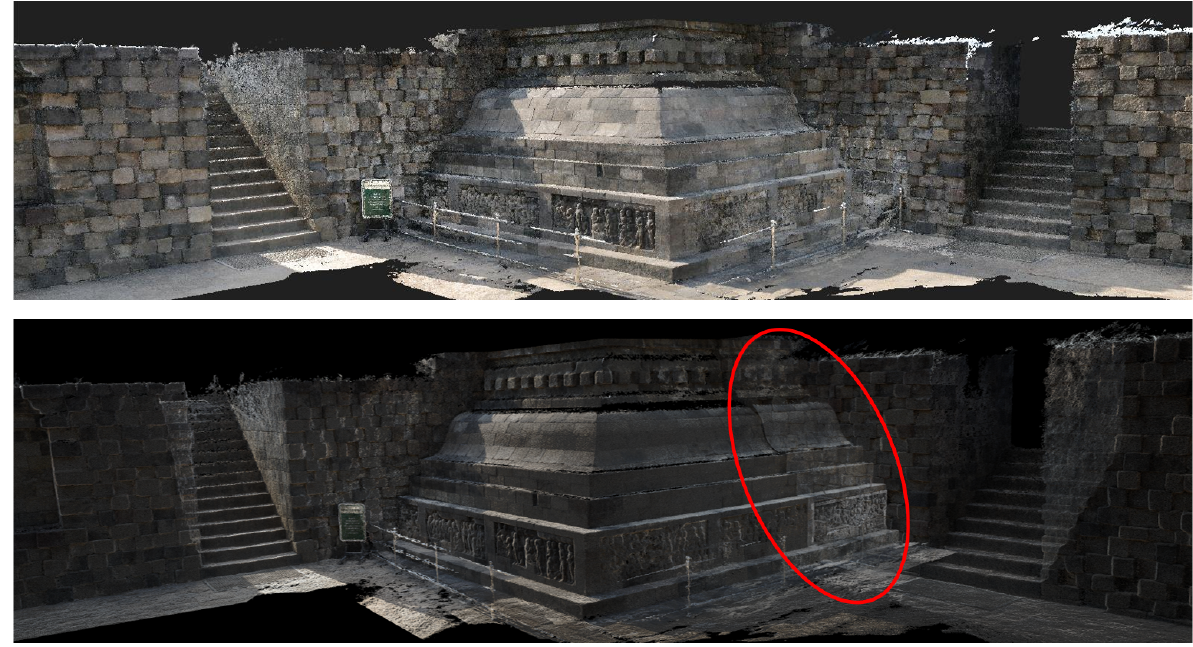
Figure 8. The fused transparent visualization result of the southeast temple wall in Borobudur. The opaque rendering result is shown on the top while the fused transparent visualization result is shown on the bottom. The reconstructed part is inside the red circle. The high resolution see-through image of this part is shown in Fig. 10.